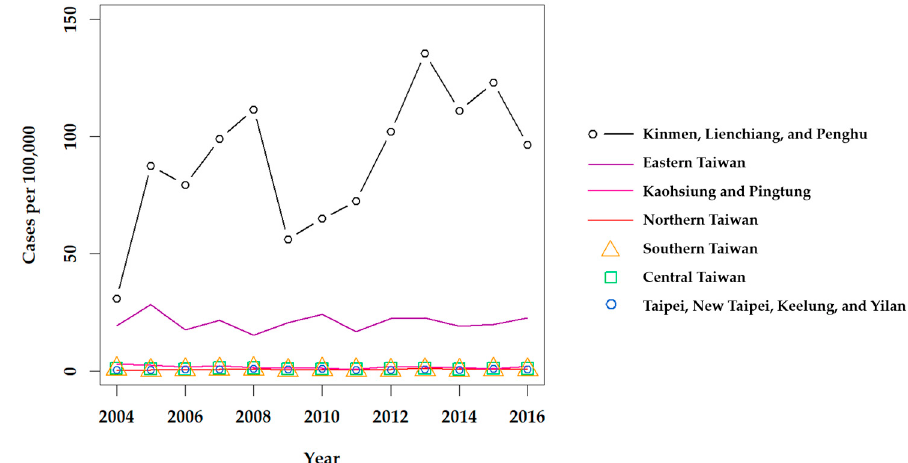
Figure 3. Annual prevalence of scrub typhus throughout Taiwan from 2004 to 2016. Confirmed indigenous cases were retrieved from the Taiwan CDC NIDSS [32]. 2010 Population and Housing Census data, retrieved from the Taiwan Statistics Bureau [34], were used to calculate the prevalence.